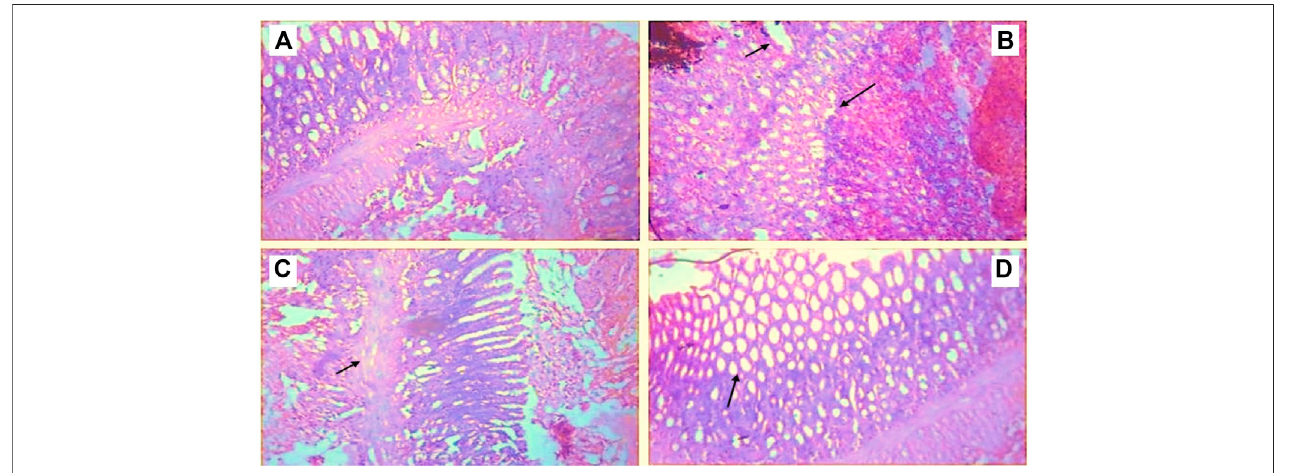
FIGURE 8 | Histopathological observations of paw tissue in control and experimental groups (A) Normal control showed a normal structure of the paw tissue, (B) CFA control displayed in fl amed cells with edema formation, (C) Butin 25 mg/kg, and (D) Butin 50 mg/kg. Both treatment groups showed almost a normal tissue structure with decreased in fl ammation and cell in fi